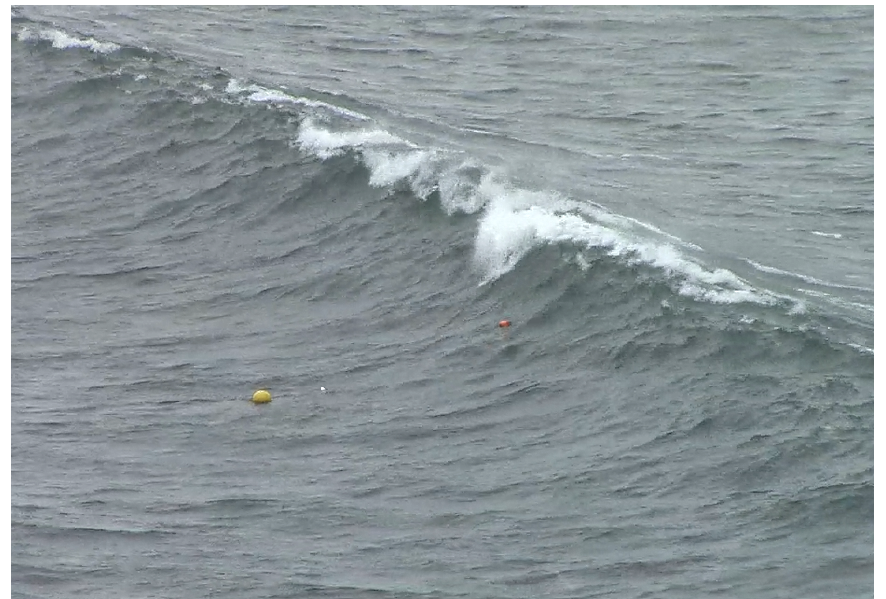
Figure 5. A breaking wave approaches the wave measurement buoy on 23 February 2014. The image is a screen capture from the recorded